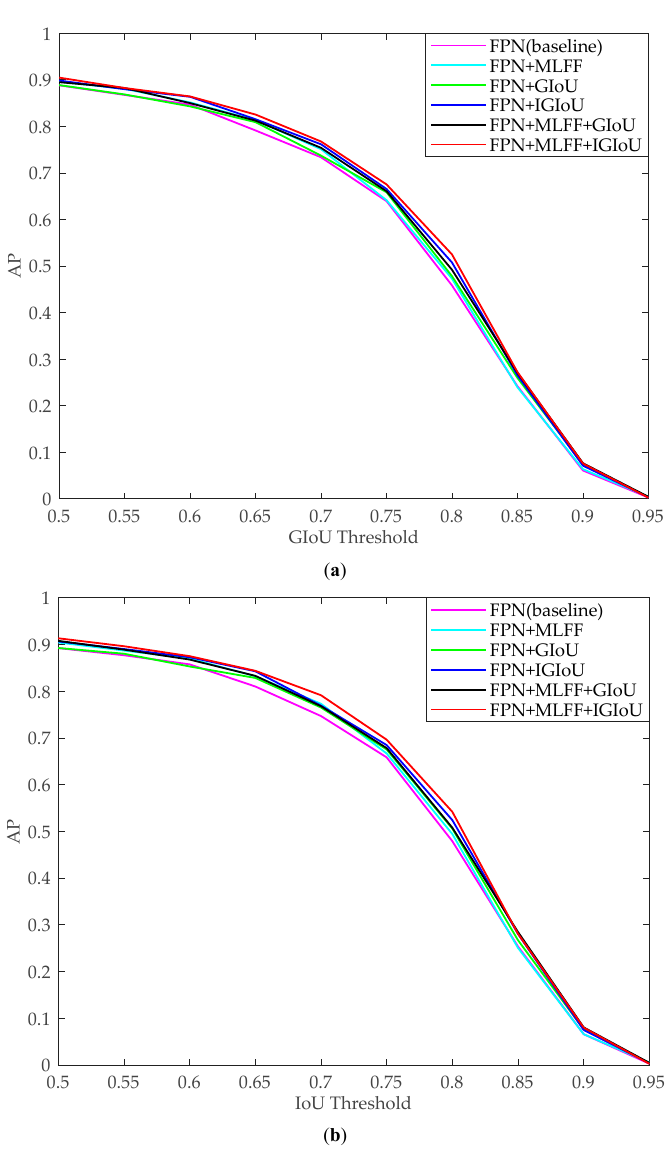
Figure 6. Comparison with baseline methods on NWPU VHR-10 dataset in terms of curves of AP with different GIoU (IoU) thresholds. ( a ) GIoU threshold; ( b ) IoU threshold.